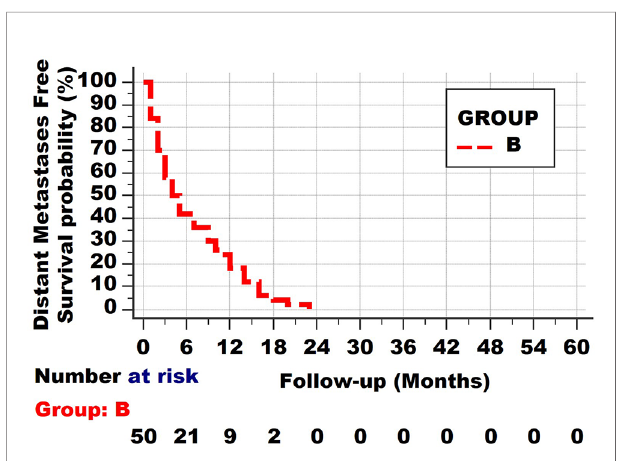
FIGURE 2 | Invasive cancer group B All patients have died from metastatic disease within 24